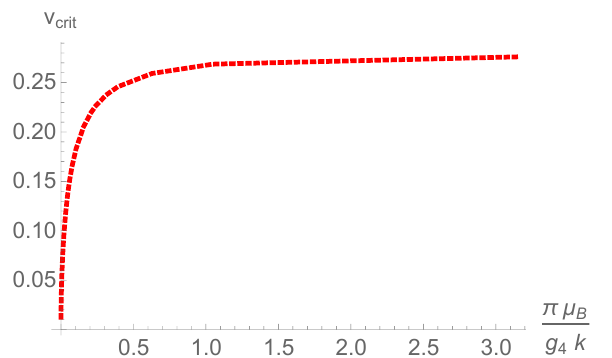
Figure 6 . The Landau critical velocity as a function of the dimensionless parameter (cid:25)(cid:22) B =g 4 k in the theory with m =